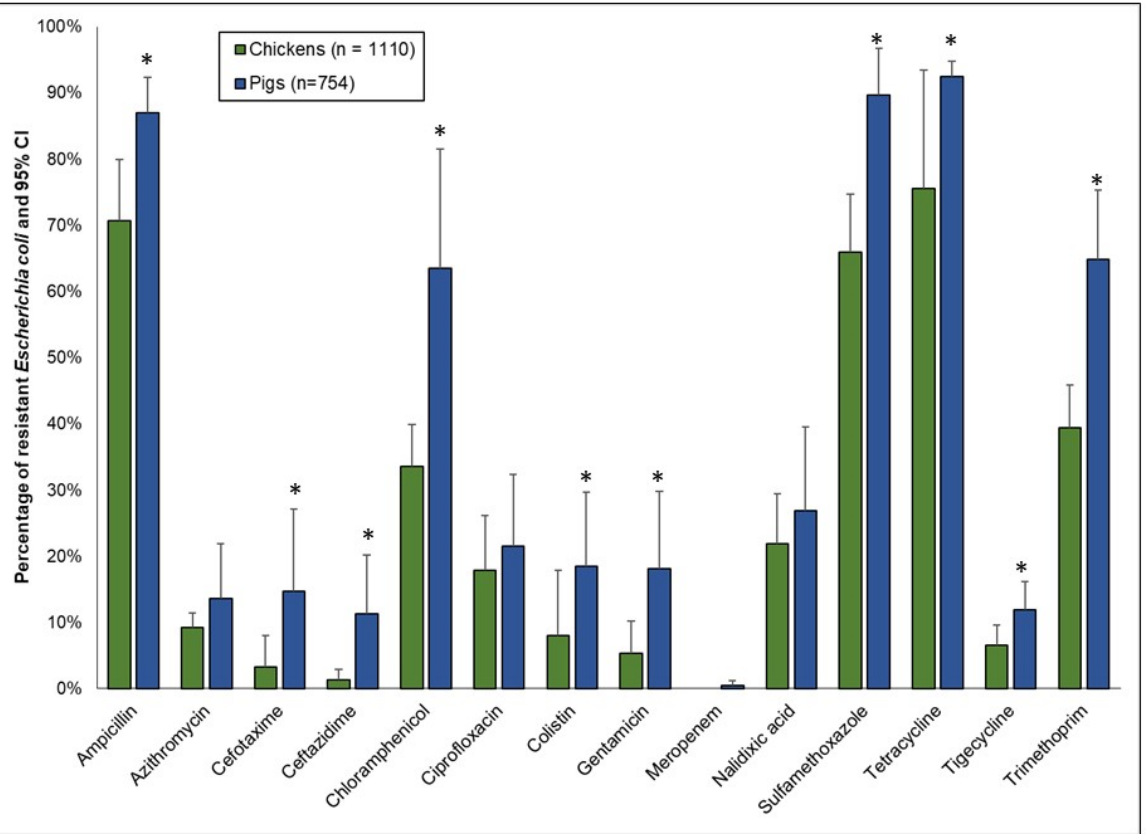
Figure 3. Percentages of antimicrobial resistance in Escherichia coli from chickens ( n = 1110; depicted by the green bars) and pigs ( n = 754; depicted by the blue bars), collected from five provinces in the Lao PDR, 2018–2021. High 95% confidence limits are shown. For each antimicrobial and animal species combination, the percentage of resistance was adjusted for clustering at the province level. Asterisks represent significant differences ( p ≤ 0.05) for a given antimicrobial between chickens and pigs.